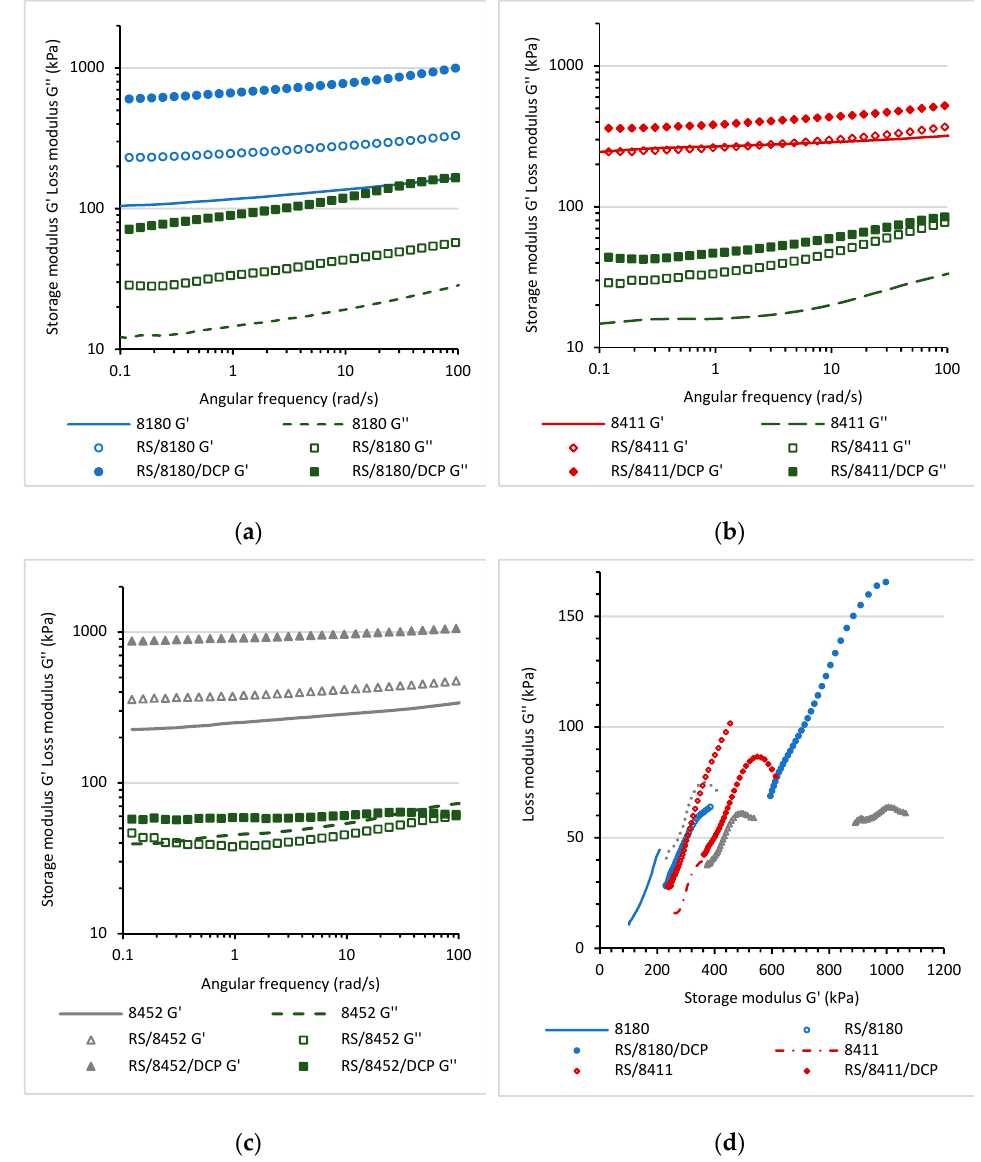
Figure 6. Dependence of the storage modulus and loss modulus of Engage 8180, RS/8180 and RS/8180/DCP blends ( a ); Engage 8411, RS/8411 and RS/8411/DCP blends ( b ); Engage 8452, RS/8452 and RS/8452/DCP blends ( c ) as a function of angular frequency and ( d ) Cole-Cole plot for the sam- ples.